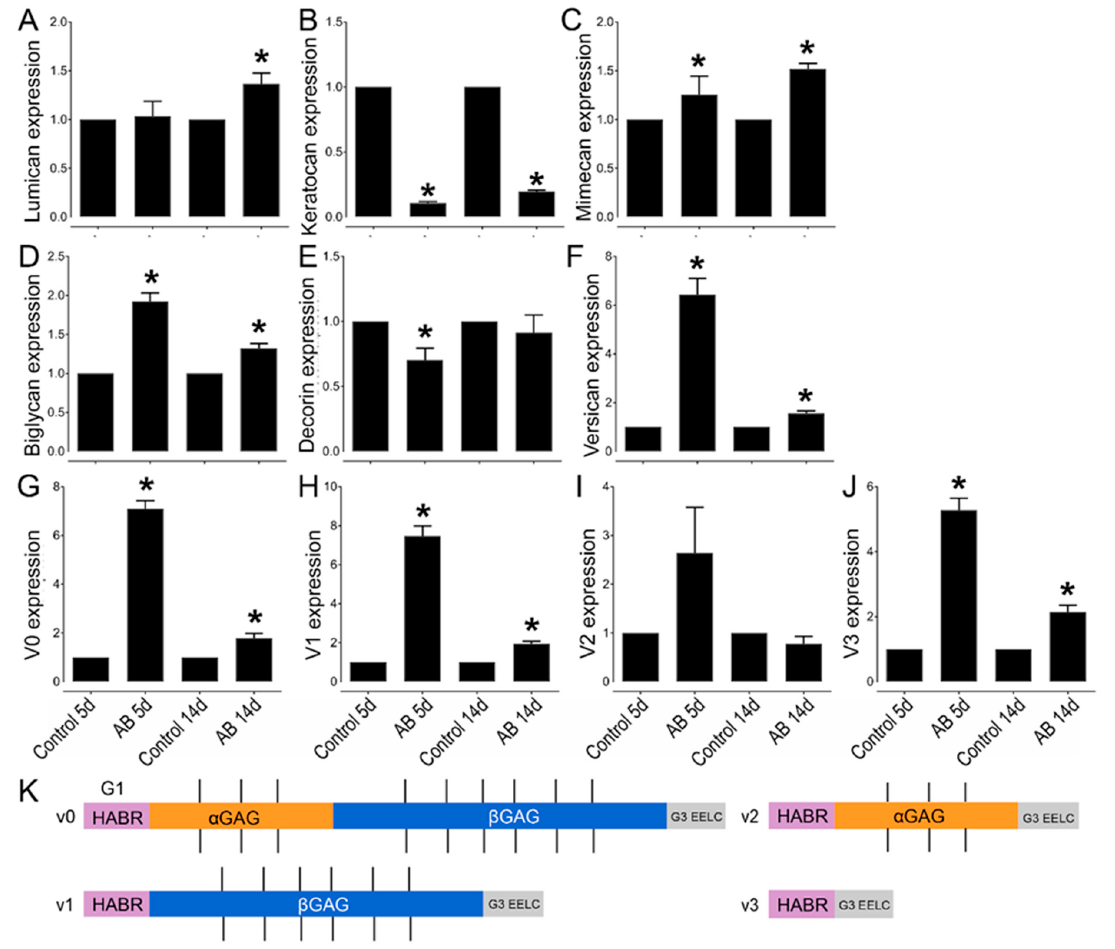
Figure 5. Relative expression profile of CSPGs and KSPGs in mouse corneas after AB. Mouse corneas were subjected to AB and analyzed after 5 and 14 days, compared to the contralateral uninjured eye. Real-time PCR (qPCR) analysis was done to verify the expression levels of lumican ( A ), keratocan ( B ), mimecan ( C ), biglycan ( D ), decorin ( E ), versican ( F ), V0 ( G ), V1 ( H ), V2 ( I ), and V3 ( J ). The relative expression levels were normalized against the arithmetic mean of GAPDH and beta-actin using the 2 −ΔΔ Ct method. * represents p ≤ 0.05. Five corneas were analyzed per experimental group. Schematic representation of the different domains of versican spliced variants ( K ). The different variants bind to HA via the G1 domain (HABR—pink). The CS-bearing domains GAG α (orange) and GAG β (blue) are represented with the CS chains as black straight lines. Finally, the G3 domain (gray) contains epidermal growth factor (EGF)-like repeats, a lectin-like motif and another HA binding domain, enabling further interactions with HA [44,45]).